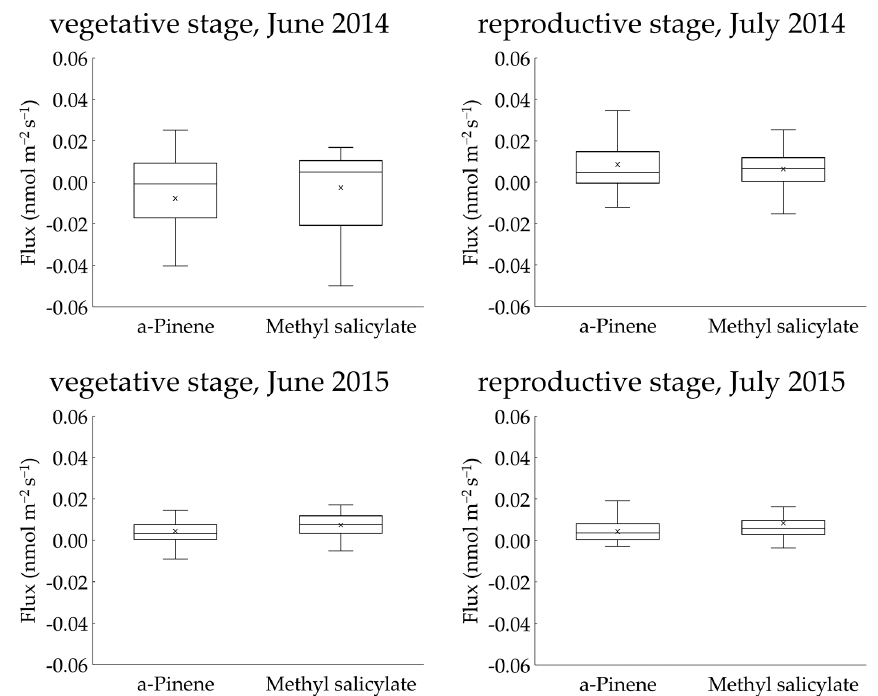
Figure 4. Interquartile ranges of upward fluxes of α -pinene and methyl salicylate measured above a rice paddy using the REA method.